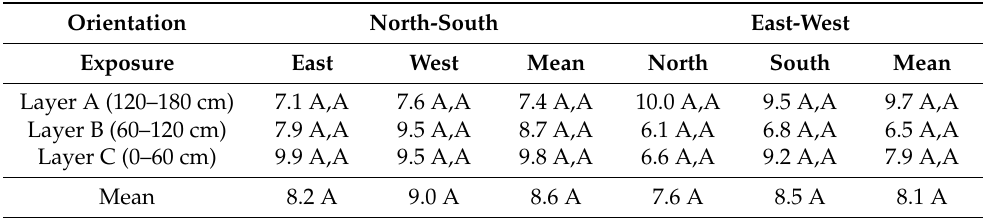
Table 14. Mean percentage of double seeds (DS, %). The first letters denote significant differences between layers for a given exposure; the second letters denote significant differences between exposures for a given layer (SNK test). Lower case letters denote statistical differences with p = 0.05. Capital letters denote statistical differences with p =